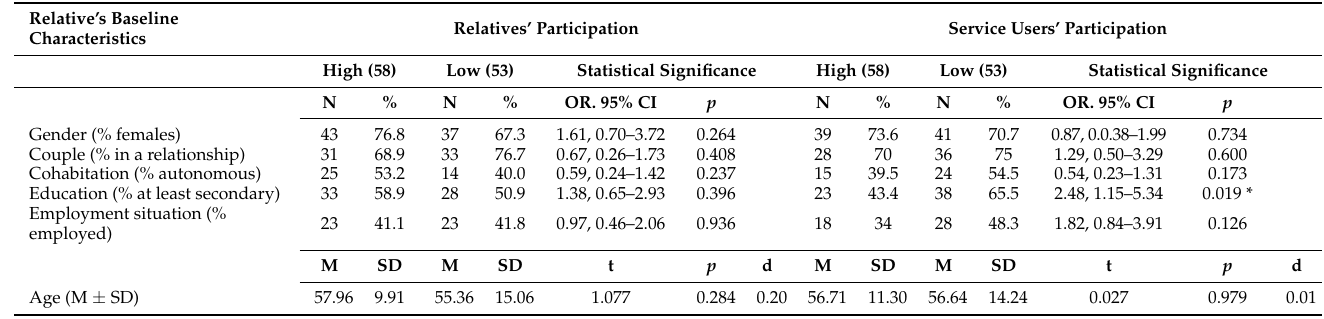
Table 2. Sociodemographic characteristics of relatives recruited into the study by level of participation of both